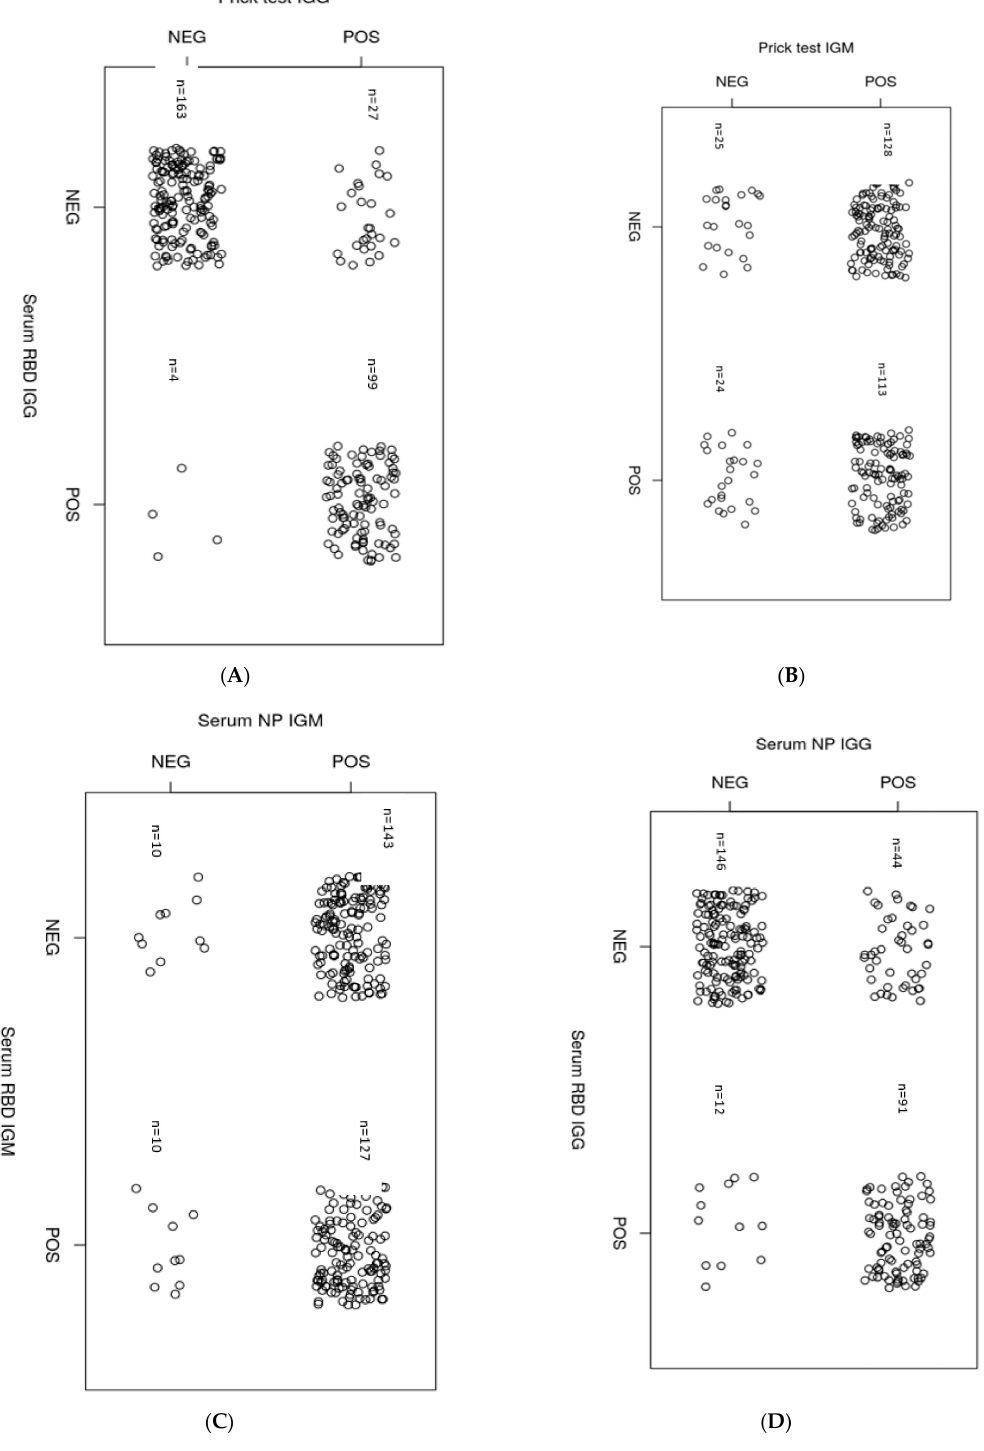
Figure 3. ( A , B ), Comparison of IgG and IgM levels on prick test versus serum against Spike S-RBD using serological tests. ( C , D ), Comparison of IgM and IgG levels against the nucleocapsid protein (NP) and spike receptor-binding domain (S-RBD) proteins in serum. To determine Cohen’s kappa coefficient (k) a statistical test was